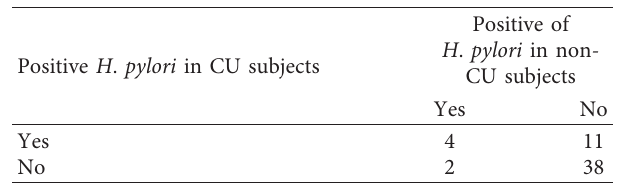
Table 2: Presence of H . pylori in paired cases and controls (55 matched pairs).